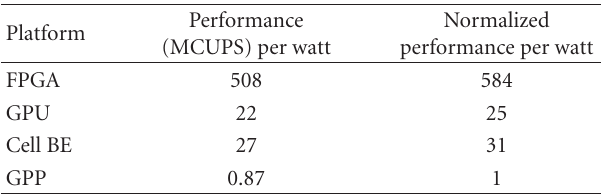
Table 10: Performance per watt figures of the Smith-Waterman algorithm implementation on all four technologies.